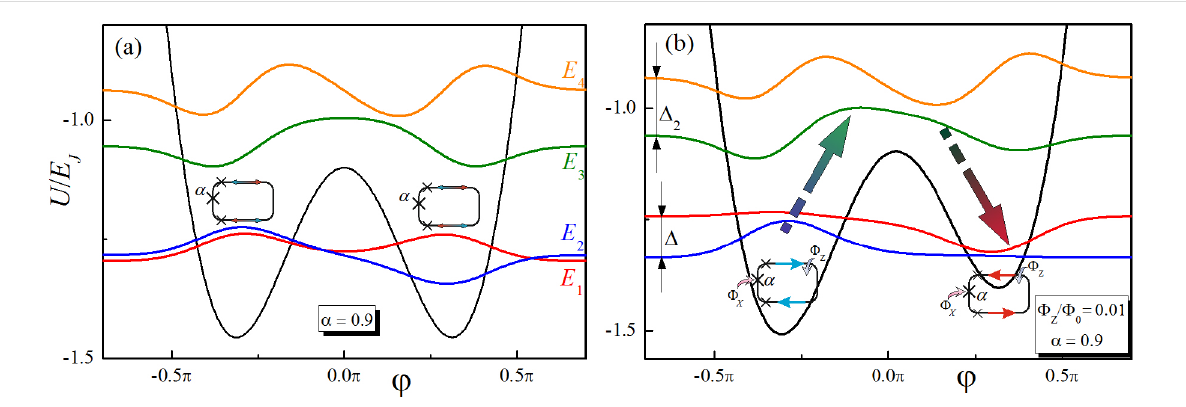
Figure 1: (a) The potential energy and the eigenfunctions (with energies E 1 , E 2 , E 3, E 4 ) of the three-junction qubit (described in [3]), where Josephson energies of the elements are E Jos , E Jos and α E Jos ( α = 0.9, junctions depicted as crosses). The characteristic Josephson energy E Jos is 80 times larger than the characteristic Coulomb energy of the heterostructures. φ is the generalized coordinate associated with the Josephson junction phases. (b) A “Not”-operation in a double-well potential of the flux-driven superconducting meta-atom ( α = 1.5) is shown as a transition between the states with certain values of the magnetic moment (these states correspond to the energy levels of E 1 and E 2 , respectively). Applied adjusting magnetic flux, Φ Z , equal to 0.01 of the magnetic flux quantum, Φ 0 . We present here illustrations of the notations used in the text: E 1, E 2 , E 3, E 4 , Δ , Δ 2